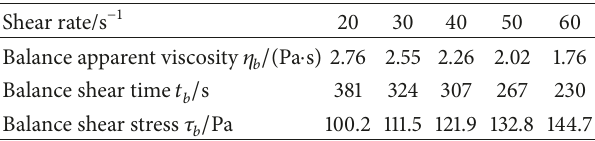
Table 4: The balance rheological parameters of PLTS. Shear rate/s −1 20 30